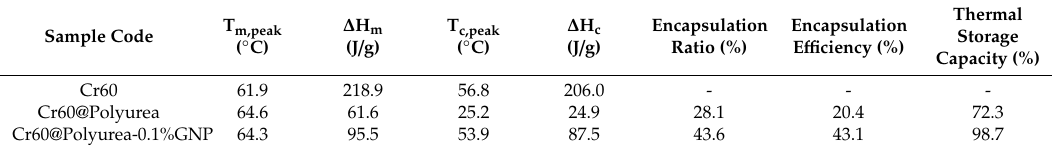
Figure 5. DSCcurvesofencapsulatedCrodatherm60, polyurea, andcapsulesincludingpolyuria-0.1%GNP. Figure 5. DSC curves of encapsulated Crodatherm60, polyurea, and capsules including polyuria- 0.1%GNP. Table 1. Thermal properties of pure and encapsulated Table 1. Thermal properties of pure and encapsulated Cr60.